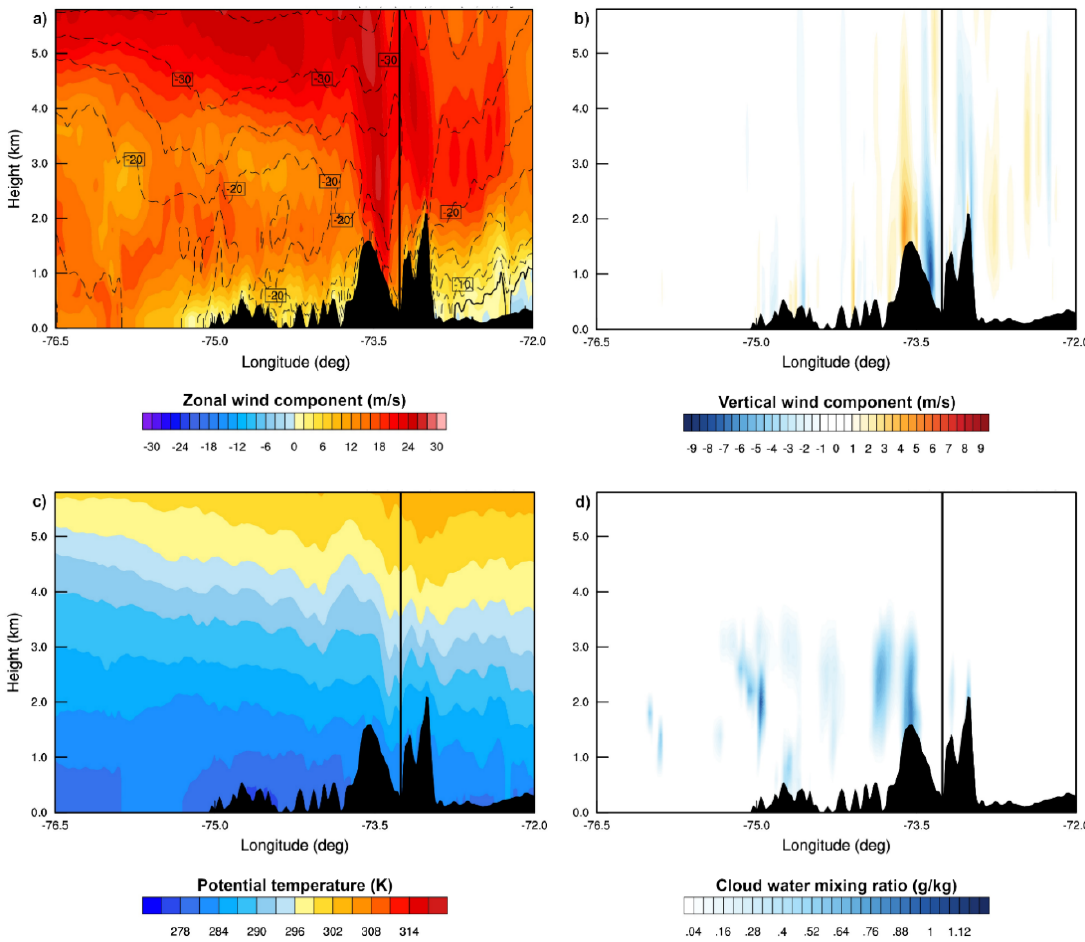
Figure 5. Vertical cross section (90° angle) of ( a ) zonal (color scheme) together with meridional (contour lines) wind component, ( b ) vertical wind component (positive values reveal upward motion, negative values reveal downward motion), ( c ) potential temperature, and ( d ) cloud water mixing ratio for the supercritical case at 20th July 2018 18:00. The black line indicates the location of NG. Data are derived from WRF.